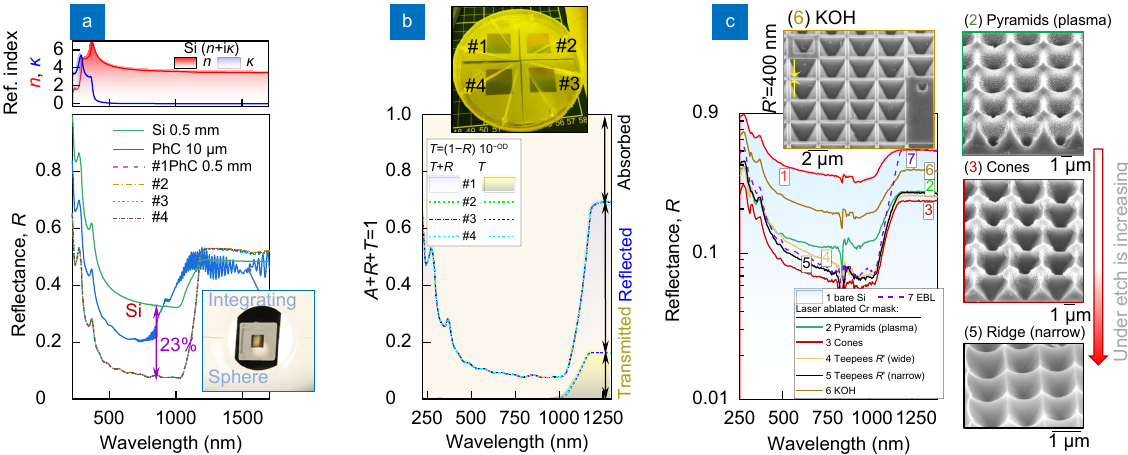
Fig. 7 | Spectral characterisation of PhC light trapping. ( a ) Reflectance R measured with an integrating sphere for a Si wafer, PhC on SoI (see Fig. 1(c)), and PhC defined by EBL. Note all four segments (top inset in (b)) showed the same (overlapping) spectral profile. Top inset shows ( n + i κ ) components 27 . Interference fringes of SoI sample are defined by Si thickness t = λ 1 λ 2 /[2 n ( λ 2 − λ 1 )] ≈ 11 μm (near-IR; n = 3.46). ( b ) Portions of reflected R (measured), transmitted T (measured) and absorbed A = 1 − R − T portions. Inset shows a photo of the 4-inch wafer with 4 EBL defined PhCs. ( c ) Reflectance of different PhC patterns prepared by laser writing and EBL which were either plasma and wet etched (note lg-axis for R ). The light spot size on the sample was 2−3 mm in diameter in order to reproduce the same conditions on samples with different areas (see the inset in (a) showing sample illuminated inside the measurement